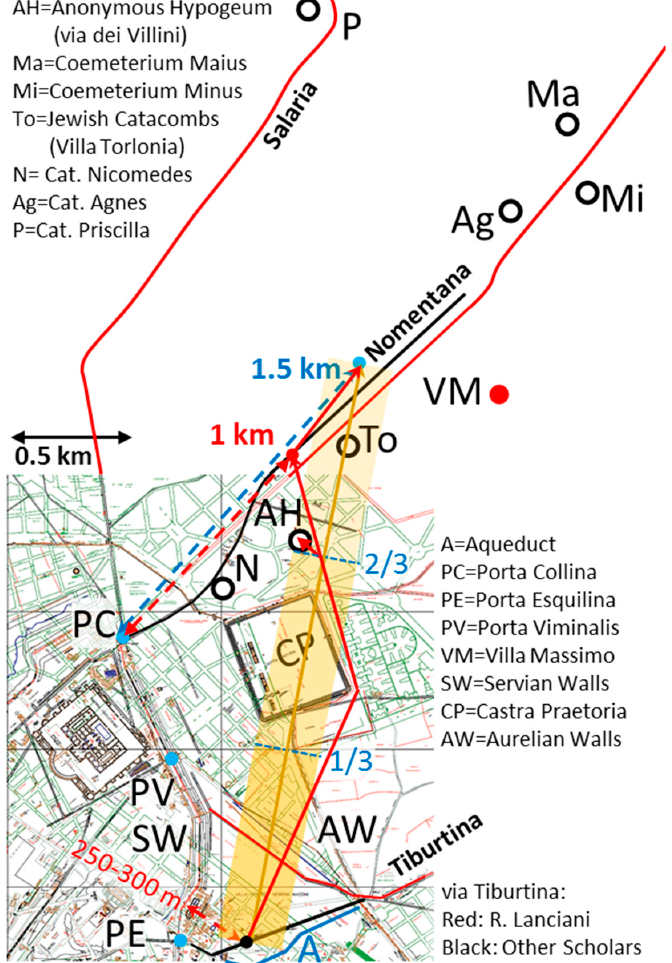
Figure 6. Map of Rome drawn by Lanciani [54], with the main archaeological sites. The red line ending with an arrow represents the rural road described by Maria Valtorta, which connects Via Tiburtina to Via Nomentana. The black circles indicate the main catacombs near the two consular roads. In black, the path of the ancient Via Nomentana, different from the current one (in red). The red and blue dashed lines represent the distances indicated by Maria Valtorta: 1.0 km when Peter reaches the consular road; 1.5 km when he disappears from view for the downhill path a little further North of the consular road. It is also shown the aqueduct (blue lines) which flows south of Via Tiburtina, exiting from Porta Esquilina. The dark yellow band indicates the line-of-sight distance between the begin and the end of Peter’s path. At 2/3 of this band, a small red arrow indicates the detour path (100–150 m) leading to the point where Peter hits his stick to the ground, Peter’s first burial site according to Maria Valtorta’s MWs.